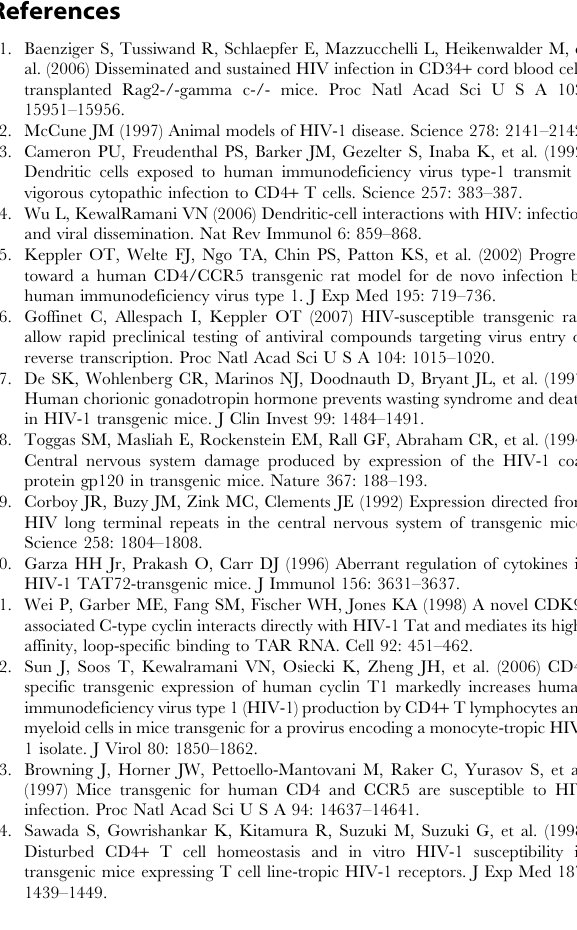
Figure S3 PI3K mediated pathways are important for HIV-1 infection in primary mouse T cells. CD4 + T cells from hCyclin T1 transgenic mice were activated with anti-CD3/28 and infected with HIV-GFP (VSVG). PI3K inhibitors wortmannin and Ly294002 were added at the time of infection at concentrations indicated and removed at 24 h post infection. DMSO was used as the control. Infection efficiency was assayed by FACS for GFP expression at 48 h post